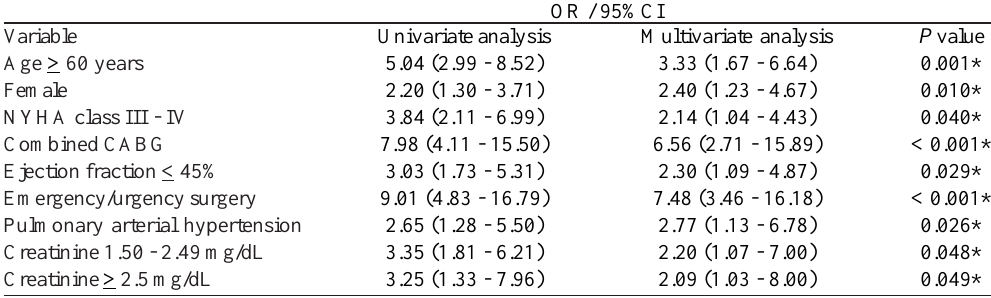
Table 3. Multivariate logistic regression model